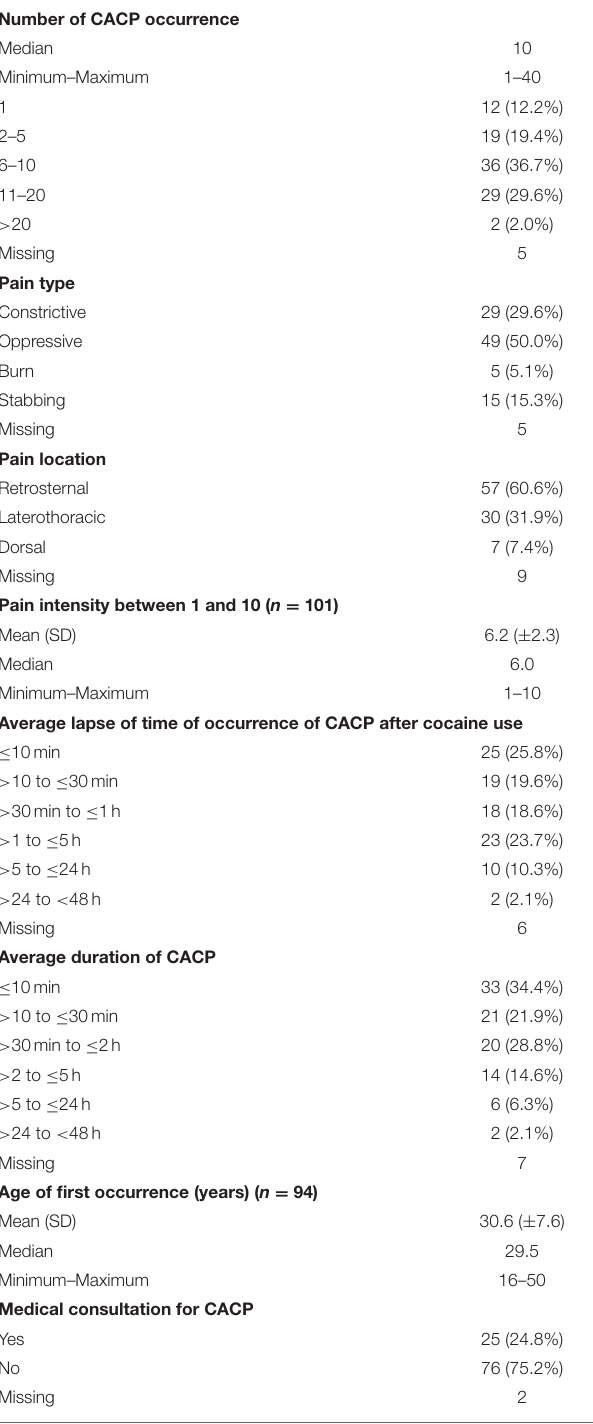
TABLE 2 | Characteristics of CACP ( n =